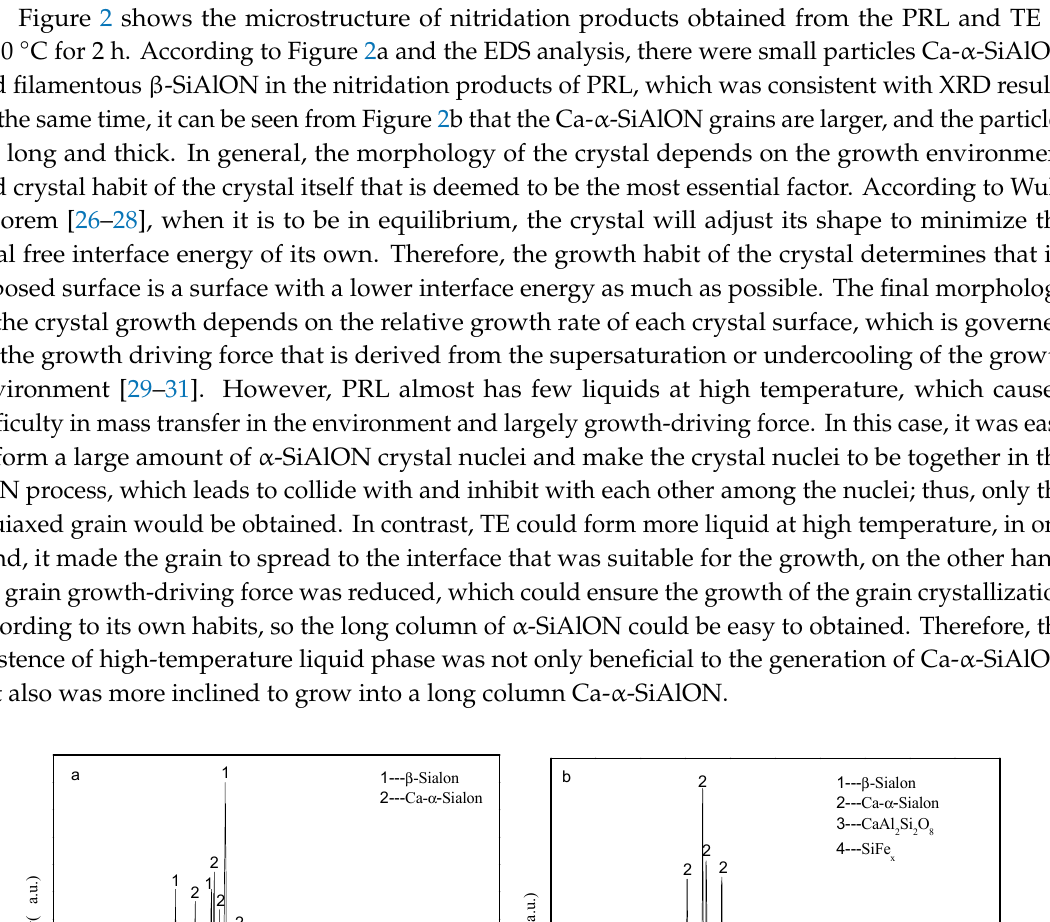
Figure 1. XRD images of the samples prepared from PRL( a ) and TE ( b ) at 1450 °C for 2 h.